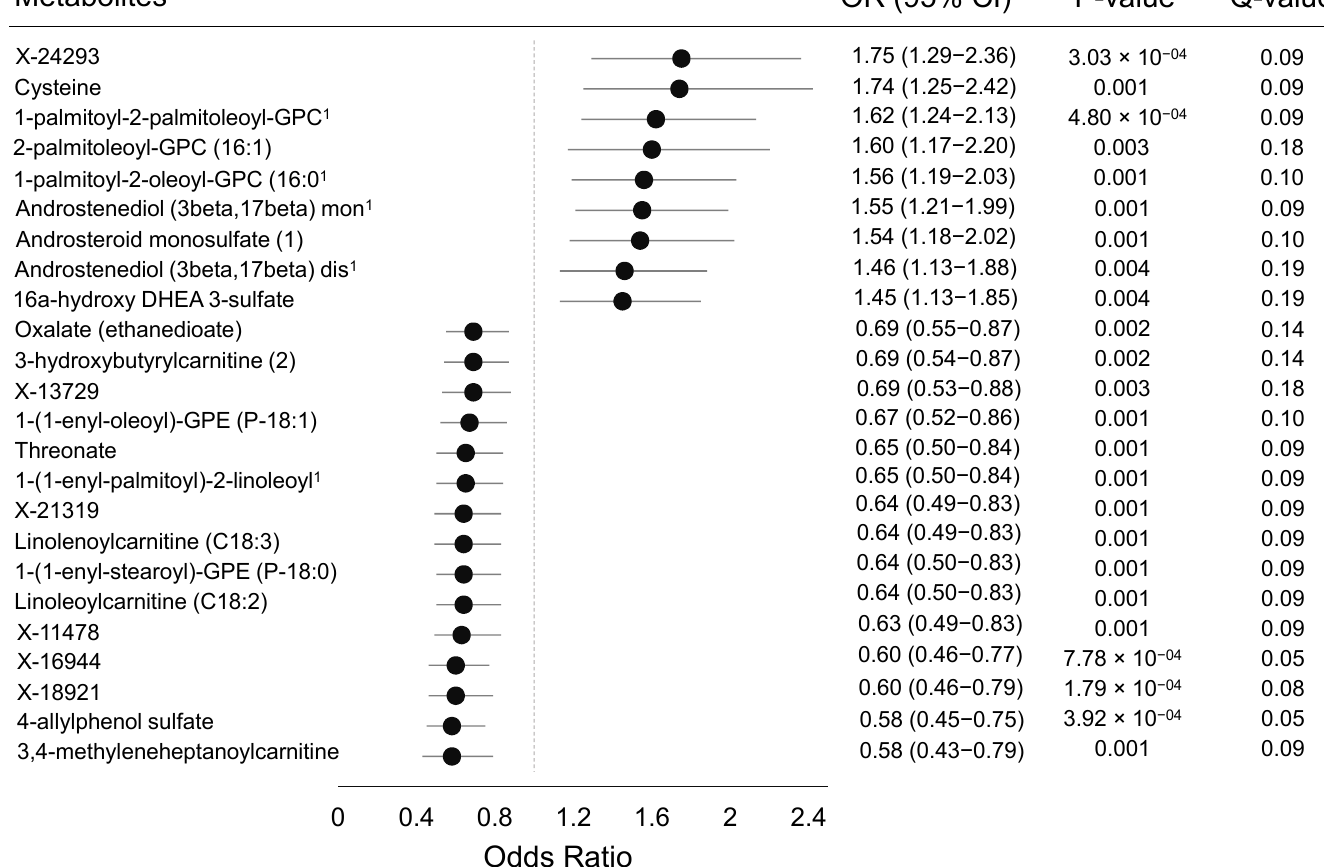
Figure 2. Odds ratios, 95% confidence intervals, p -values, and q-values for postmenopausal breast cancer when comparing the 90th with the 10th percentile levels of metabolites in conditional logistic models adjusted for age at blood draw. Results presented only for metabolites below the false discovery rate threshold of 0.20. Markers indicate the odds ratio, and error bars, the 95% confidence intervals. The q-value is the estimated probability of a false discovery. 1 Abbreviations in order of appearance: 1-palmitoyl-2-palmitoleoyl-GPC (16:0/16:1), 1-palmitoyl-2-oleoyl-GPC (16:0/18:1), Androstenediol